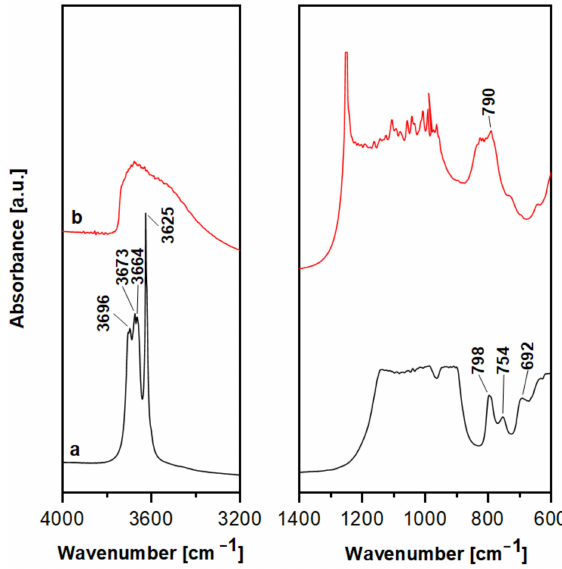
Figure 4. FT-IR spectra of kaolinite (a) and silica particles (b). Table 2. IR frequencies and assignments of kaolinite.